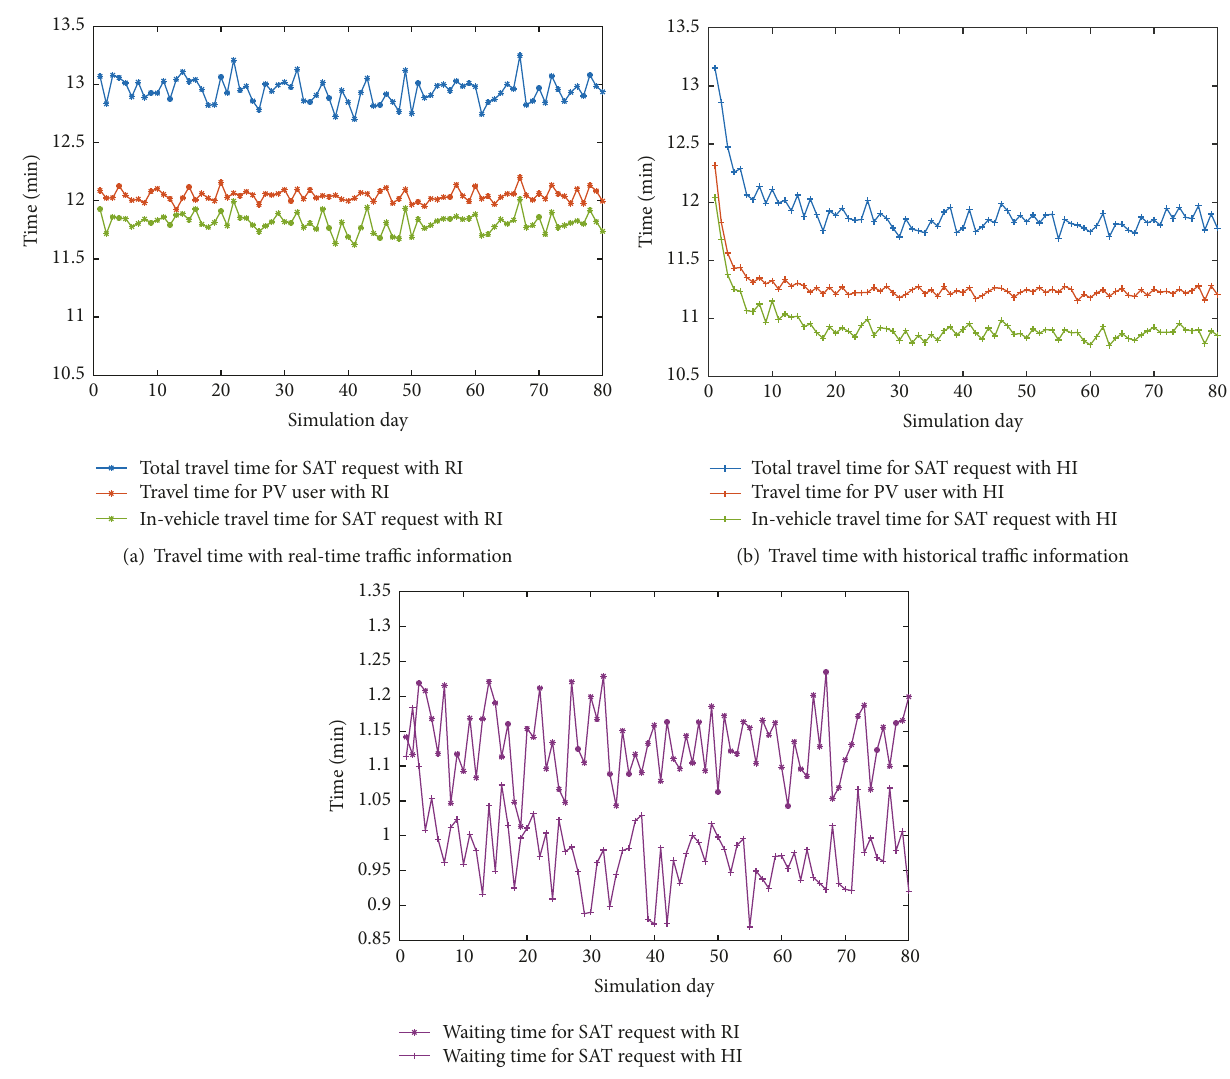
Figure 9: Day-to-day changes in (a) travel time with RI, (b) travel time with HI, and (c) waiting time for SAT request and PV user (RI: real-time information; HI: historical